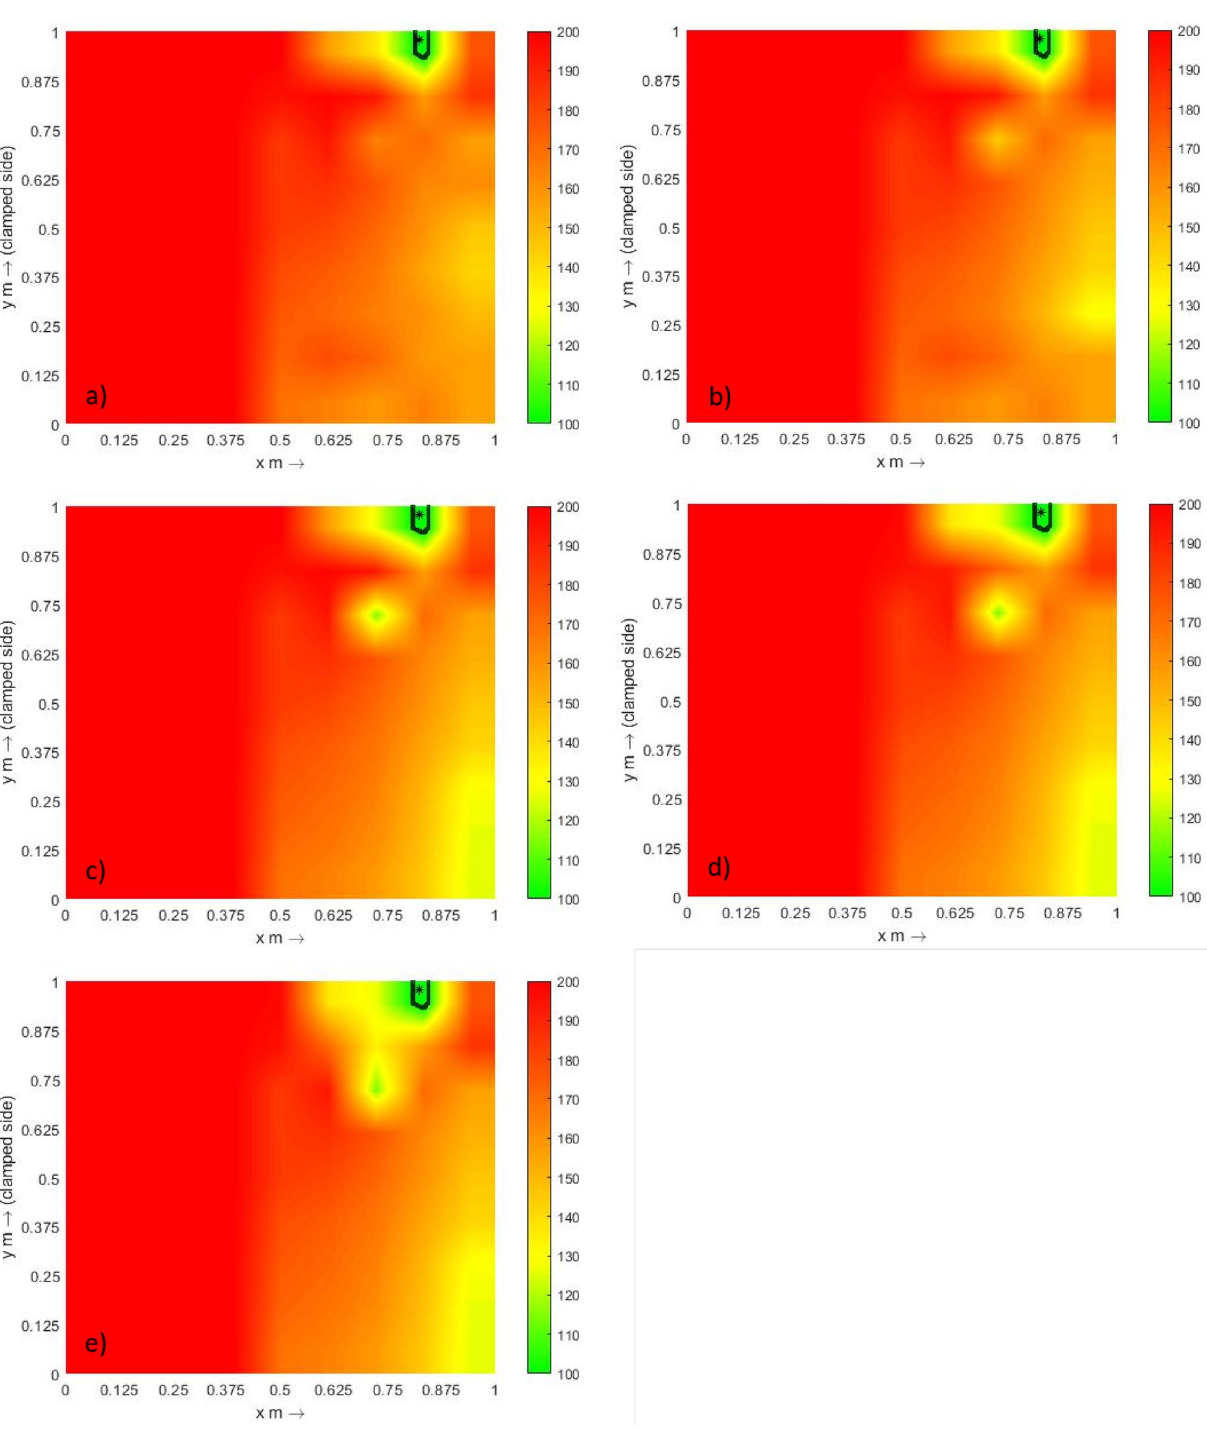
Fig. 12 Estimated region of the position of load applied for test point A using a finer grid with a deflection of a 5 mm, b 10 mm, c 15 mm, d 20 mm and e 25 mm. Asterisk marks the actual position of applied